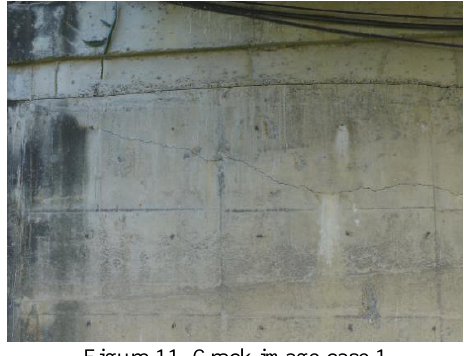
Figure 11. Crack image case 1